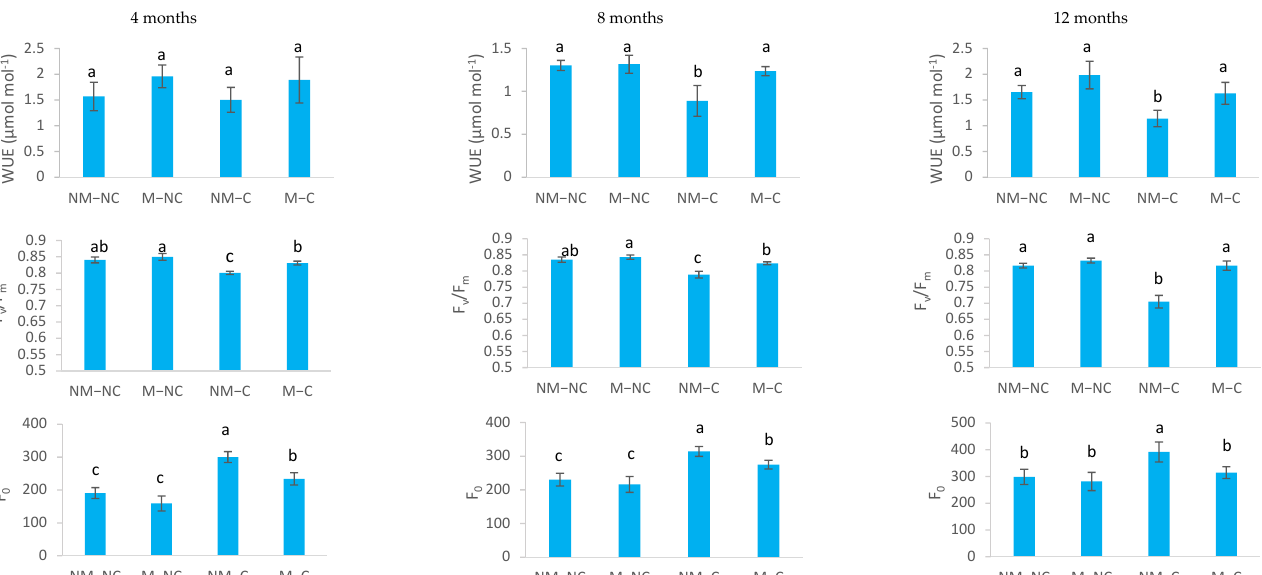
Figure 3. Water-use efficiency (WUE), the yield of photosystem II (F v /F m ) and minimum chlorophyll fluorescence (F 0 ) of ectomycorrhizal (M) and non-ectomycorrhizal (NM) Pinus halepensis seedlings after 4, 8, and 12 months of growth in contaminated (C) and control soil (NC). Means (± SD; n = 20) with different letters significantly differ from one another based on Tukey’s tests at p ≤ 0.05.